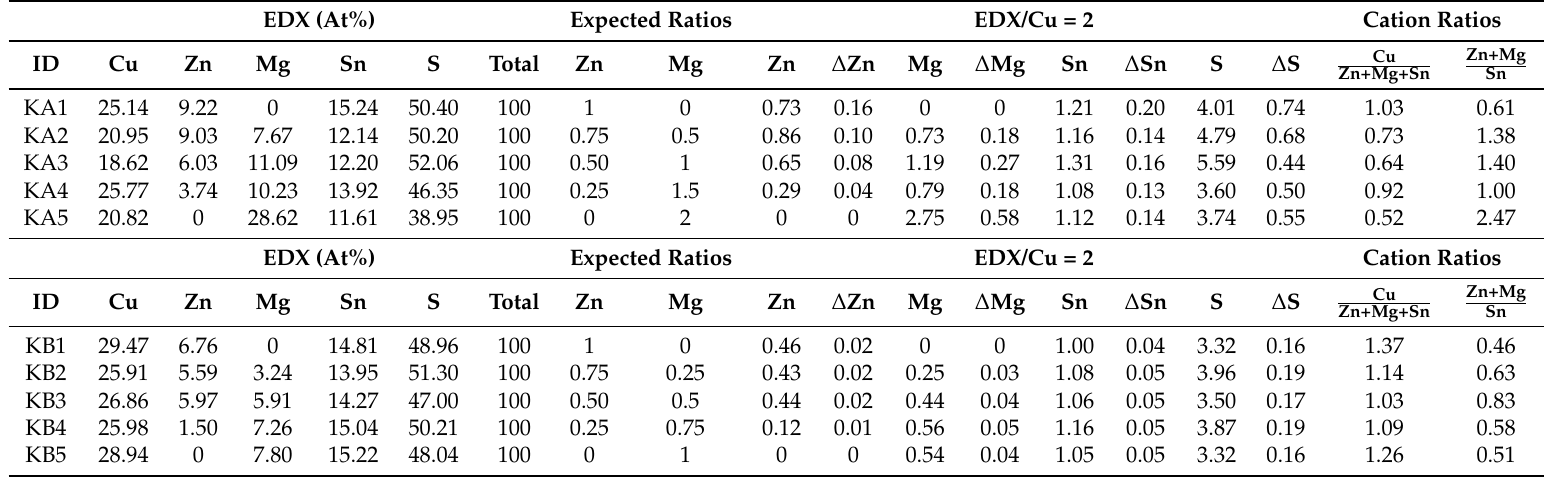
Table 1. Samples’ IDs for each series. Energy dispersive X-ray spectroscopy (EDX) atomic percentage (fist block), atomic ratio results normalized to copper as 2 with their corresponding errors (second block), and cation ratios (third block). Expected ratios for Sn and S are 1 and 4,